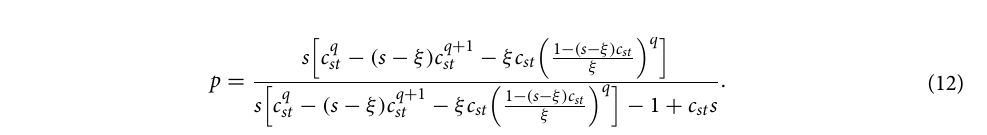
Figure 3. Steady states, given by the solution of Eq. (12), for the annealed model with q = 3 . Each row corresponds to a different number of states: s = 3 (top panels), s = 4 (middle panels), s = 5 (bottom panels). The first column represents all possible solutions indexed with different values of ξ without the distinction between the stable and unstable solutions. The remaining columns represent stationary states for initial conditions indicated in the top right corner of each panel, where α , β , γ , δ , ǫ ∈ { 0, 1, . . . , s − 1 } . Stable solutions are denoted by the solid lines, whereas the unstable ones are marked with the dashed